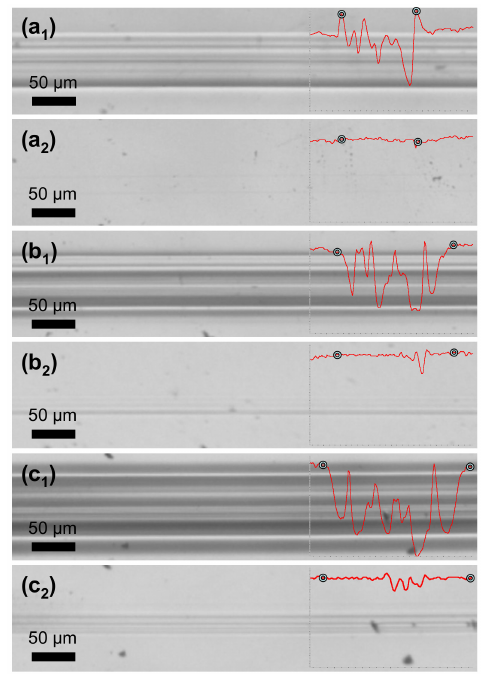
Figure 7. Scratch-healing of the crosslinked PETMP-TTT polymer coatings: ( a 1 ), ( b 1 ), and ( c 1 ) optical microscope digital photographs of characteristic scratch track sections before, and ( a 2 ), (b 2 ), and ( c 2 ) after the healing process of the scratch with different constant loading of 1.2 N, 1.5 N, and 2.7 N, respectively. Insets show characteristic scratch track profiles with corresponding indicators for the beginning and the end of scratch.